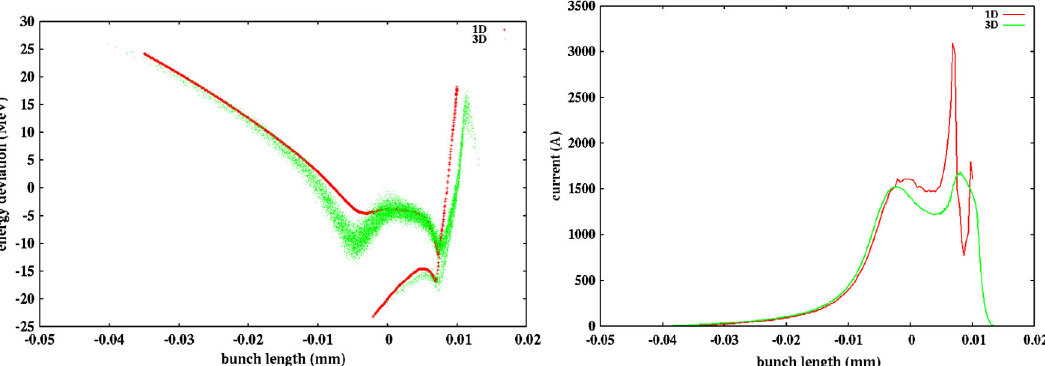
FIG. 9. Longitudinal phase space distribution (left) and current profile (right) at the entrance to undulator from the 1D model (red) and from the 3D model (green) using an optimal solution